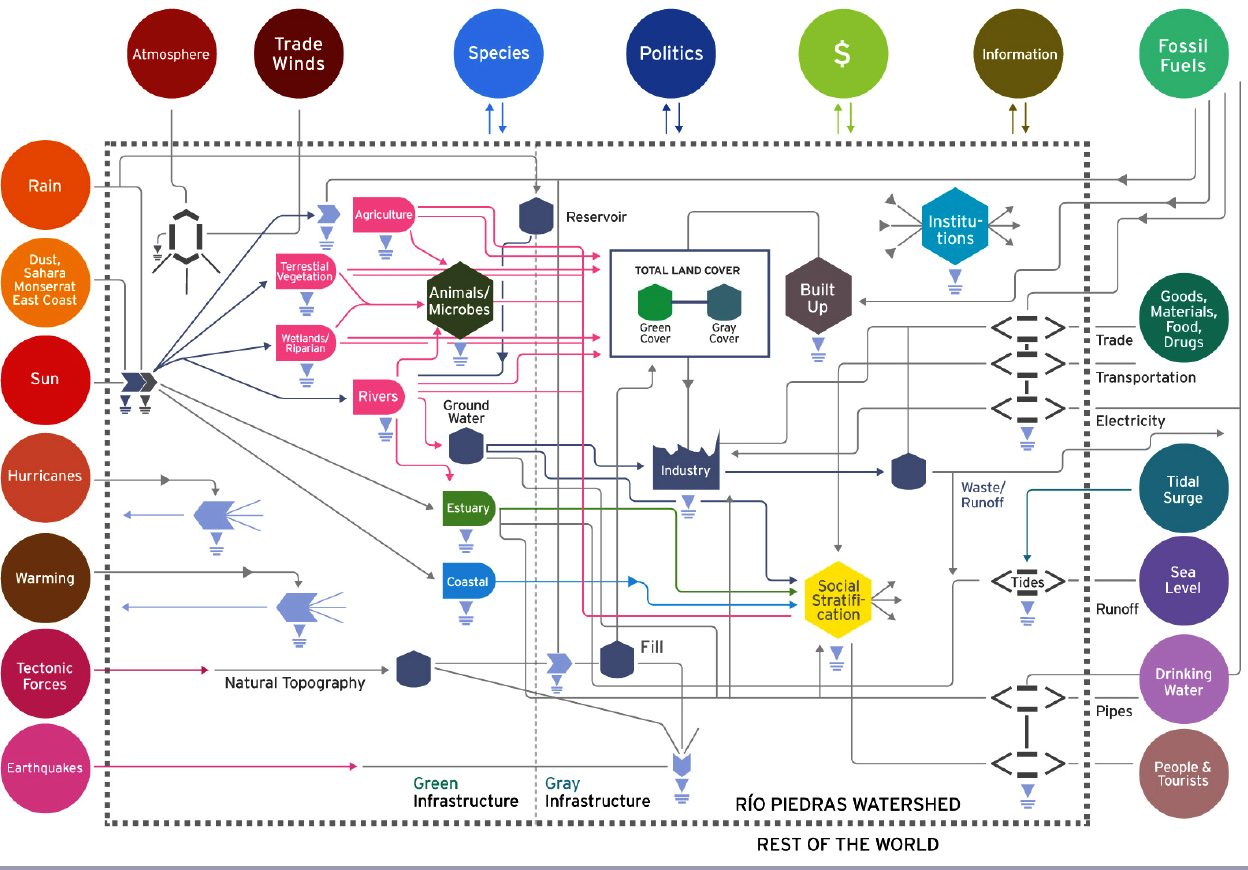
Fig. 1 . A heuristic model of the social-ecological system within the Río Piedras River Watershed. The left side of the box representing the watershed contains the ecological systems of the city, identified as green infrastructure. The right side of the diagram contains the social systems and gray infrastructure. Outside circles represent driving external forces to the watershed. Bulleted symbol represents systems with photosynthetic capacity, while hexagons represent systems that only consume energy through respiration or combustion. Tanks represent the accumulation of water, mass, waste, or land. Lines with arrows represent the flux of energy or materials. Most fluxes are unidirectional following the arrowhead. Other fluxes, like the tidal water exchange, atmospheric air ventilating the system, inflow and outflow of vehicles and people, or water flow through pipes can be bidirectional. Not all fluxes are illustrated but they are implied for the purpose of simplifying the diagram. For example, government influence and several external drivers, like policies, dollar fluxes, or information fluxes, connect with most sectors of the city but are left unconnected for simplicity. The same is true for the effects of hurricanes, earthquakes and warming. Color in the diagram is for aesthetic purposes. The text contains more